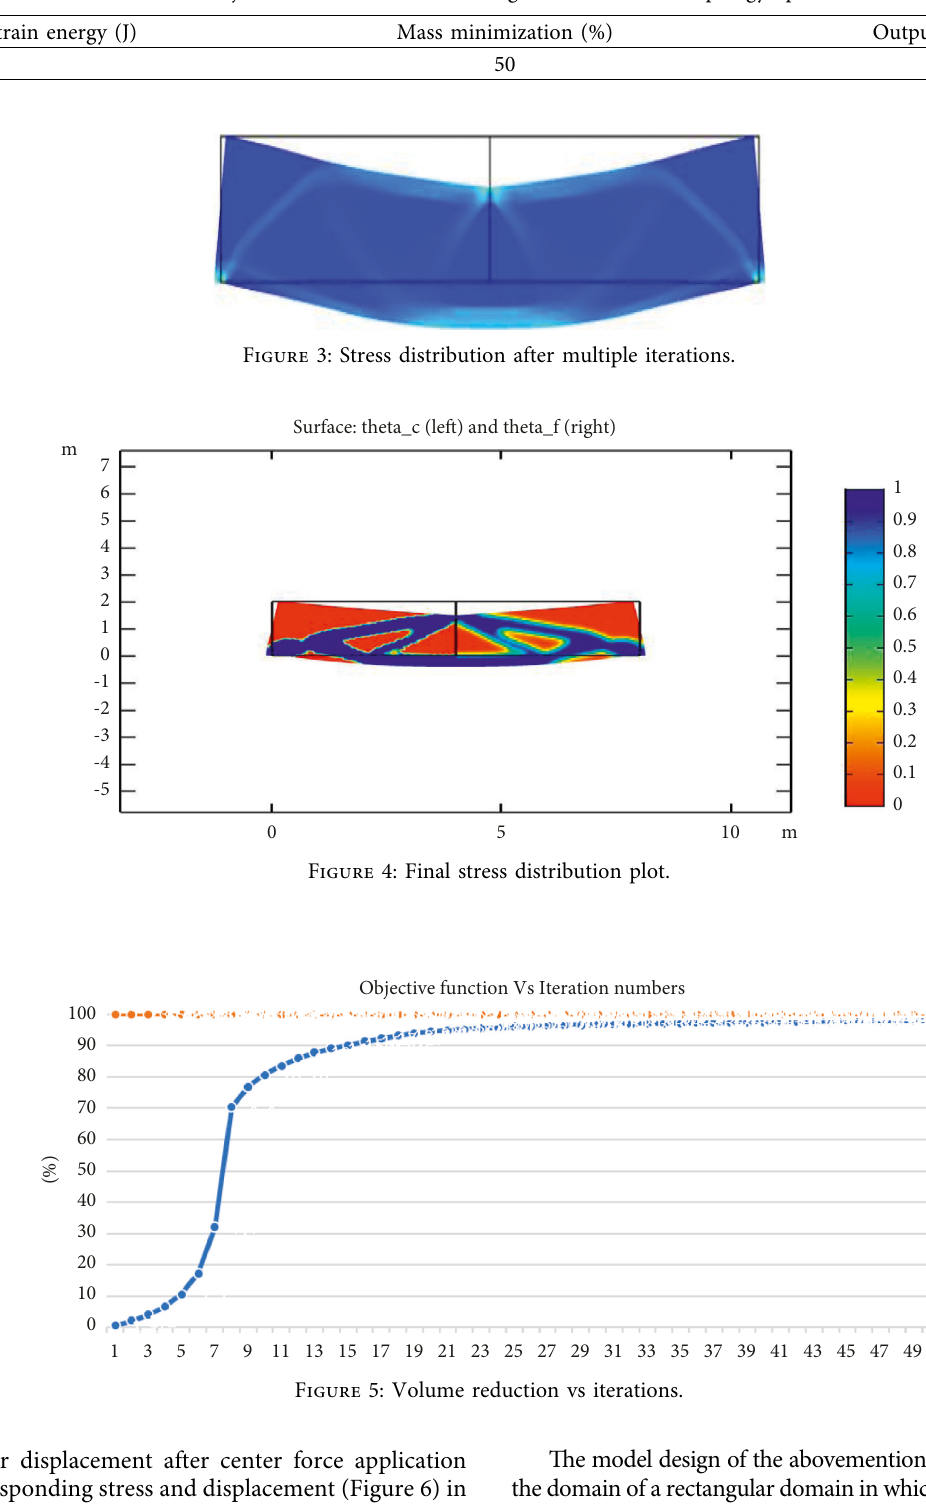
Table 1: The objective functions of the rectangular domain after topology optimization.